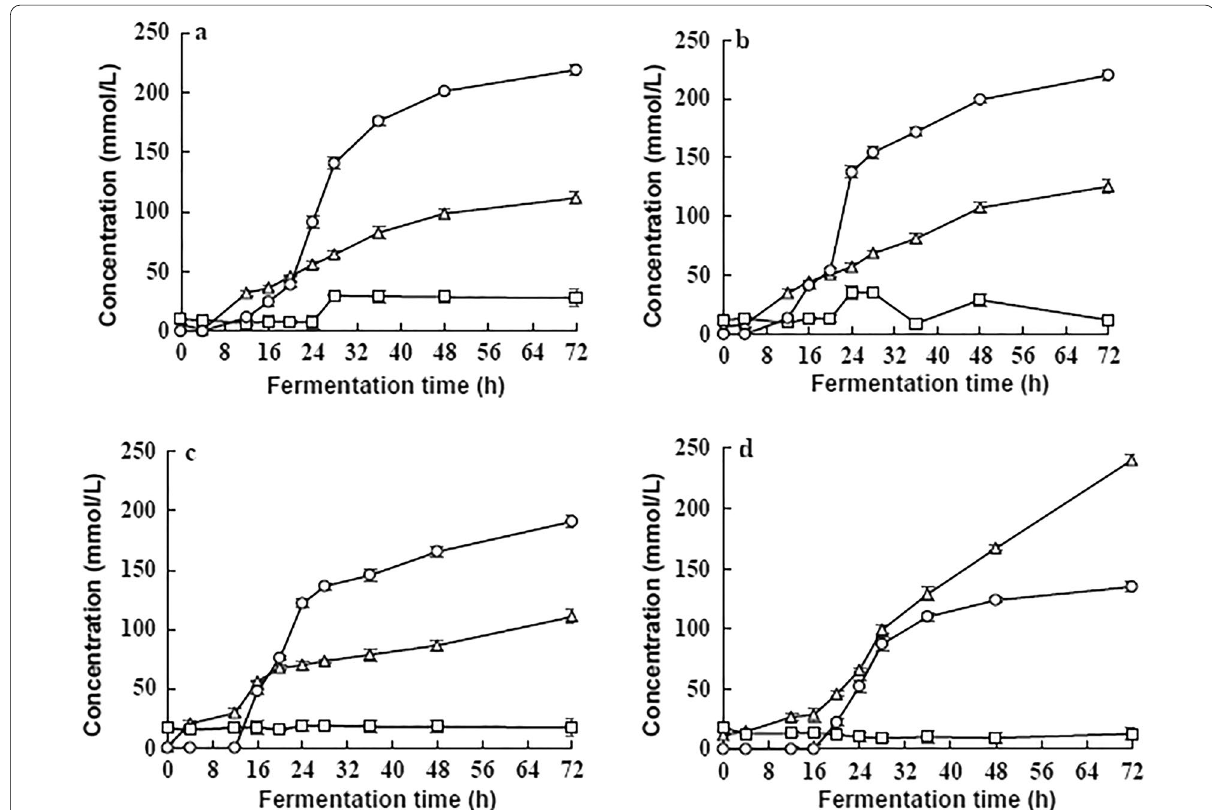
Fig. 3 Products in different concentrations of cane molasses. Products tested: Lactate